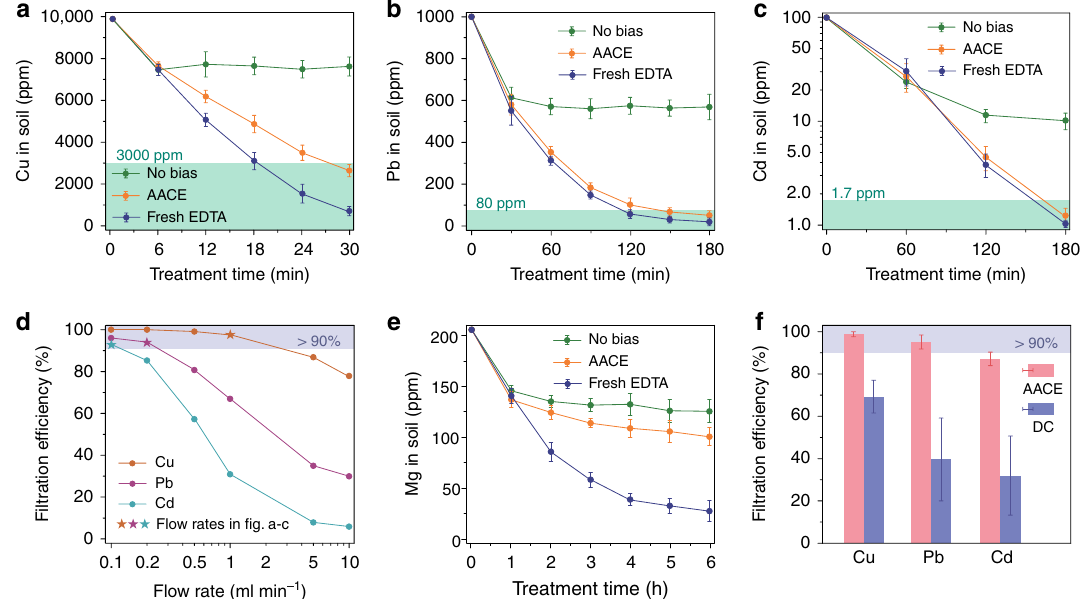
Fig. 2 Remediation performance of the AACE method. a – c Comparison between the AACE remediation and two other methods on treating three soil samples spiked with 10,000ppm Cu ( a ), 1000 ppm Pb ( b ), and 100 ppm Cd ( c ), respectively. ‘ No bias ’ , using the same experiment set up as the AACE method and no bias is applied to the electrodes. ‘ Fresh EDTA ’ , using fresh EDTA solution to wash the spiked soil without recirculation. Green region represents the CHHSL for residential scenario. d AACE fi ltration ef fi ciency (the percentage of the heavy metal cations electrodeposited by the AACE fi lter from the washing ef fl uent) as the function of soil washing fl ow rate. The highest fl ow rate providing a fi ltration ef fi ciency above 90% was chosen for the corresponding treatment. e Concentration of Mg in soil under three different treatment methods. Flow rate, 0.1 ml min − 1 . f Comparison of the fi